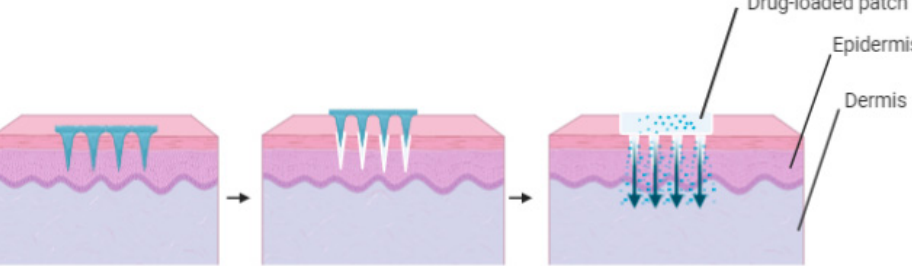
Figure 2. Solid microneedle device designed to create microchannel pores on the skin, then followed by transdermal patch application.